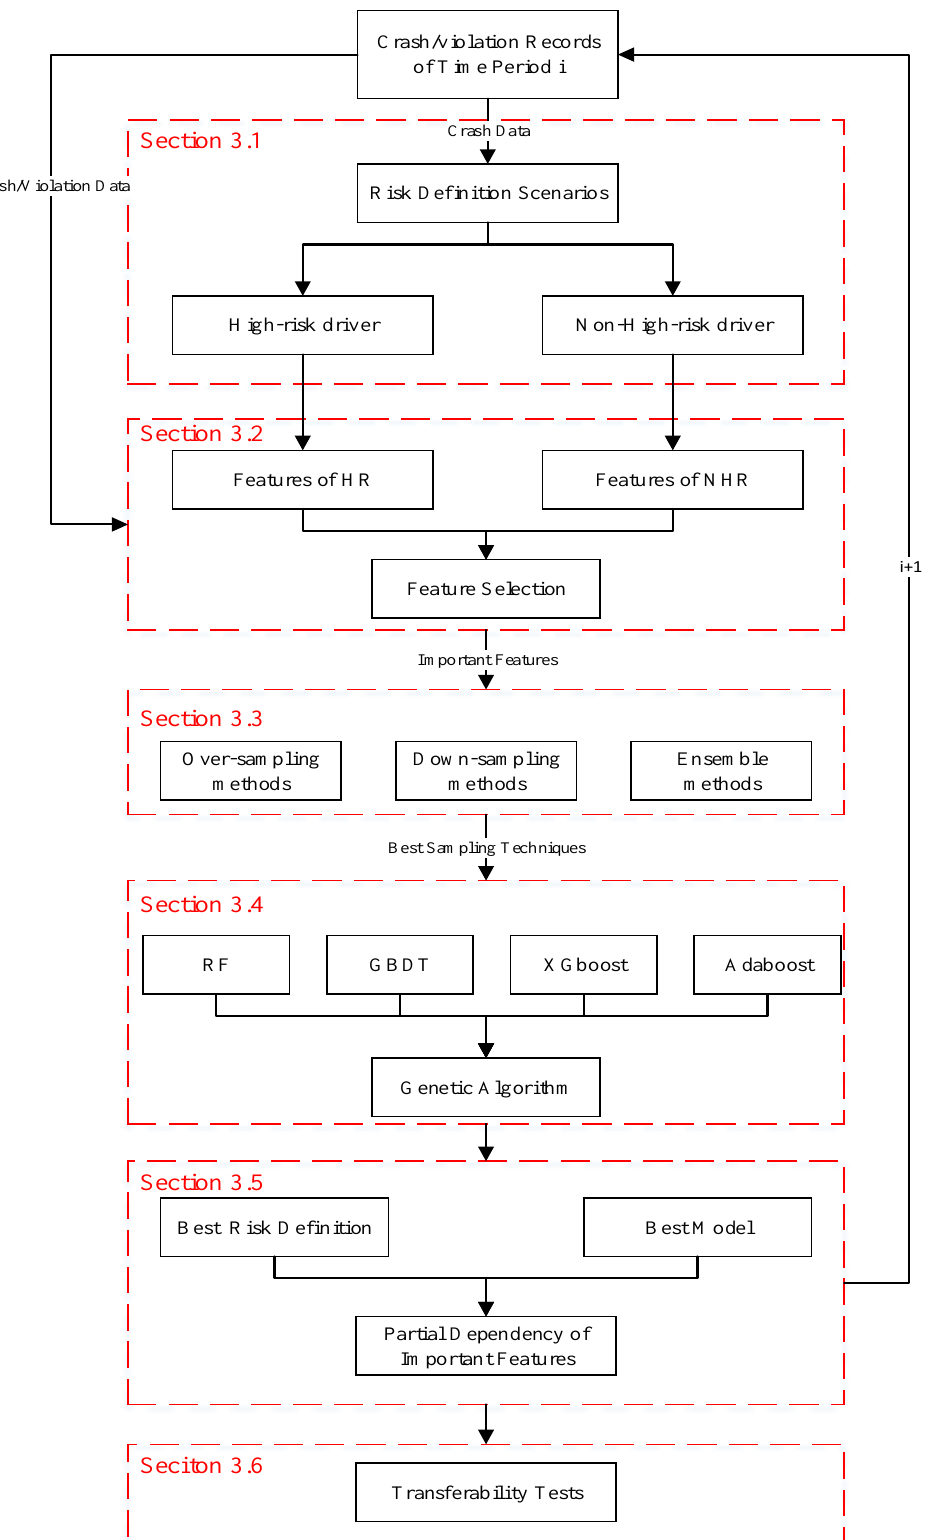
Figure 2. A general framework of model development and analysis.